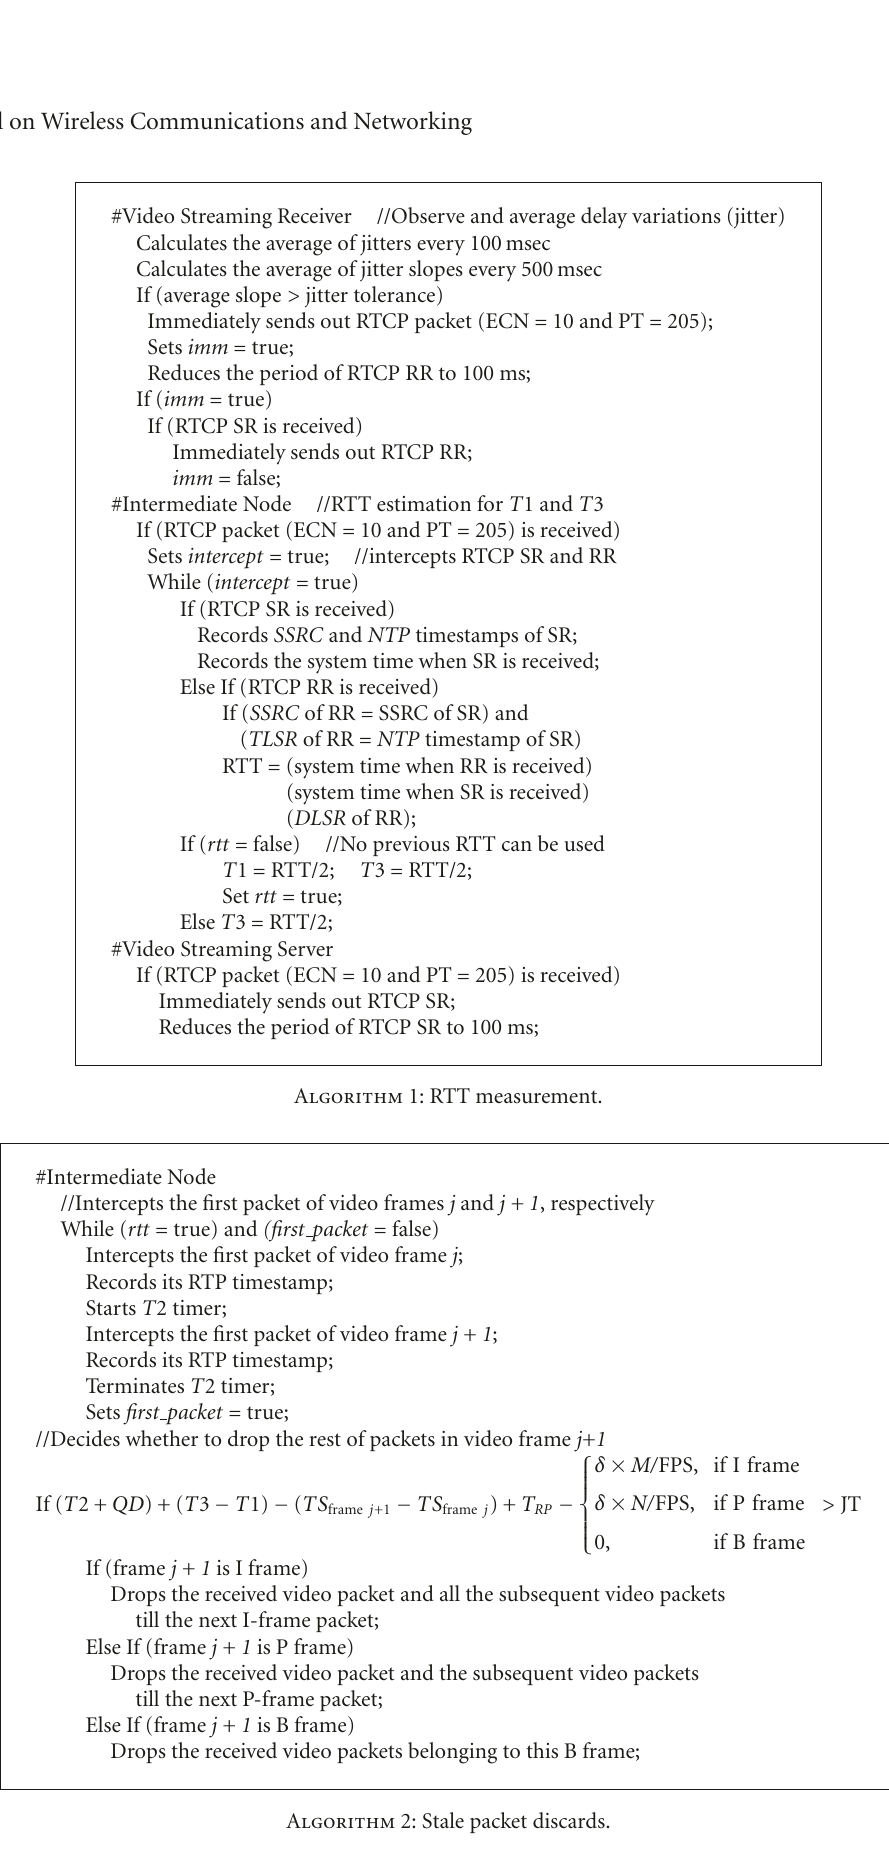
Algorithm 2: Stale packet